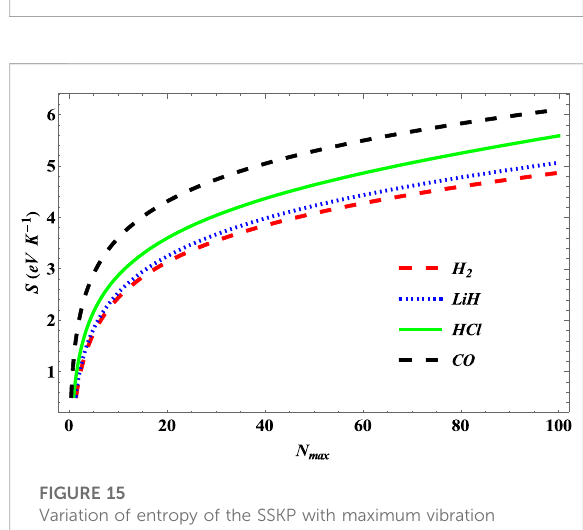
FIGURE 14 Variation of internal energy of the SSKP with maximum vibration quantum number for different diatomic molecule systems with n = 2 and l = 1.